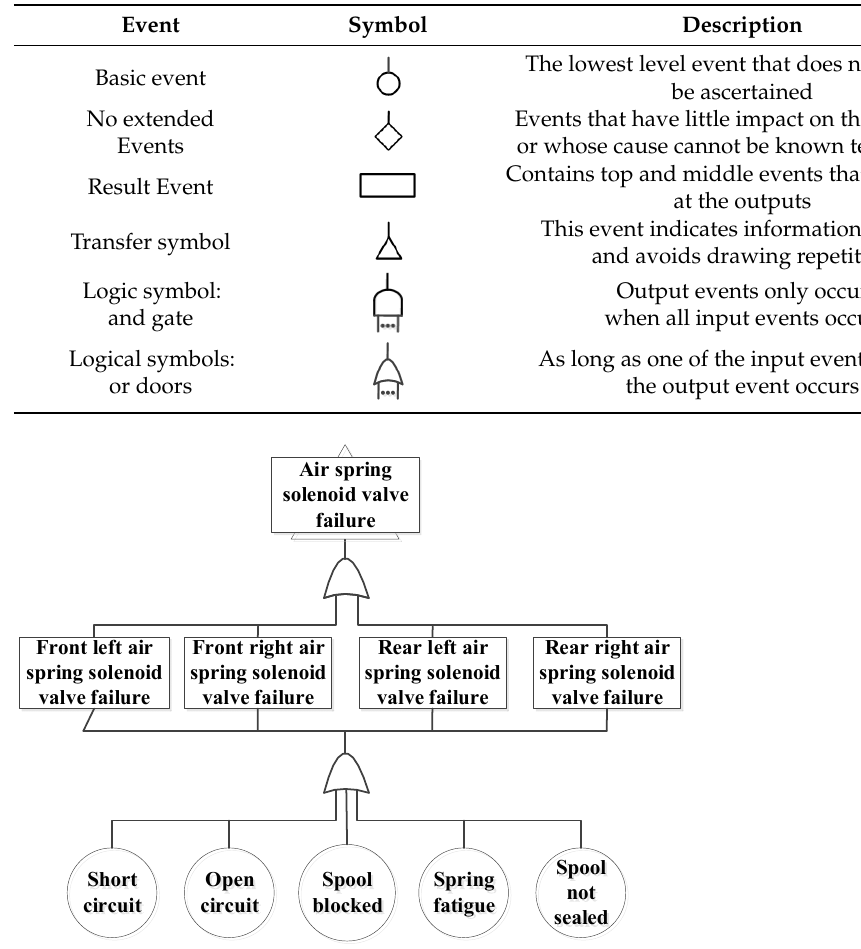
Figure 3. Fault tree of solenoid valves for air spring system.